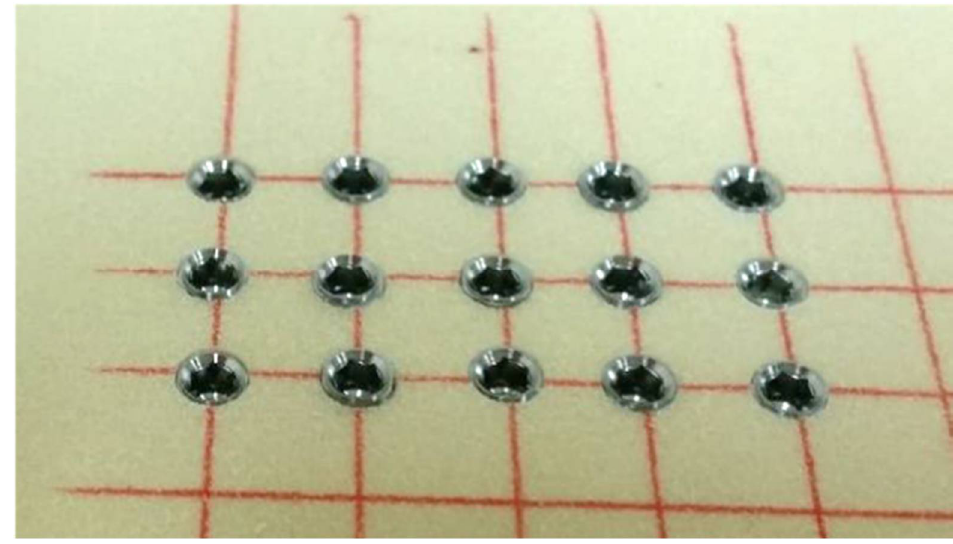
Figure 3. Fifteen implants were examined for any deviation from the acceptance criteria.